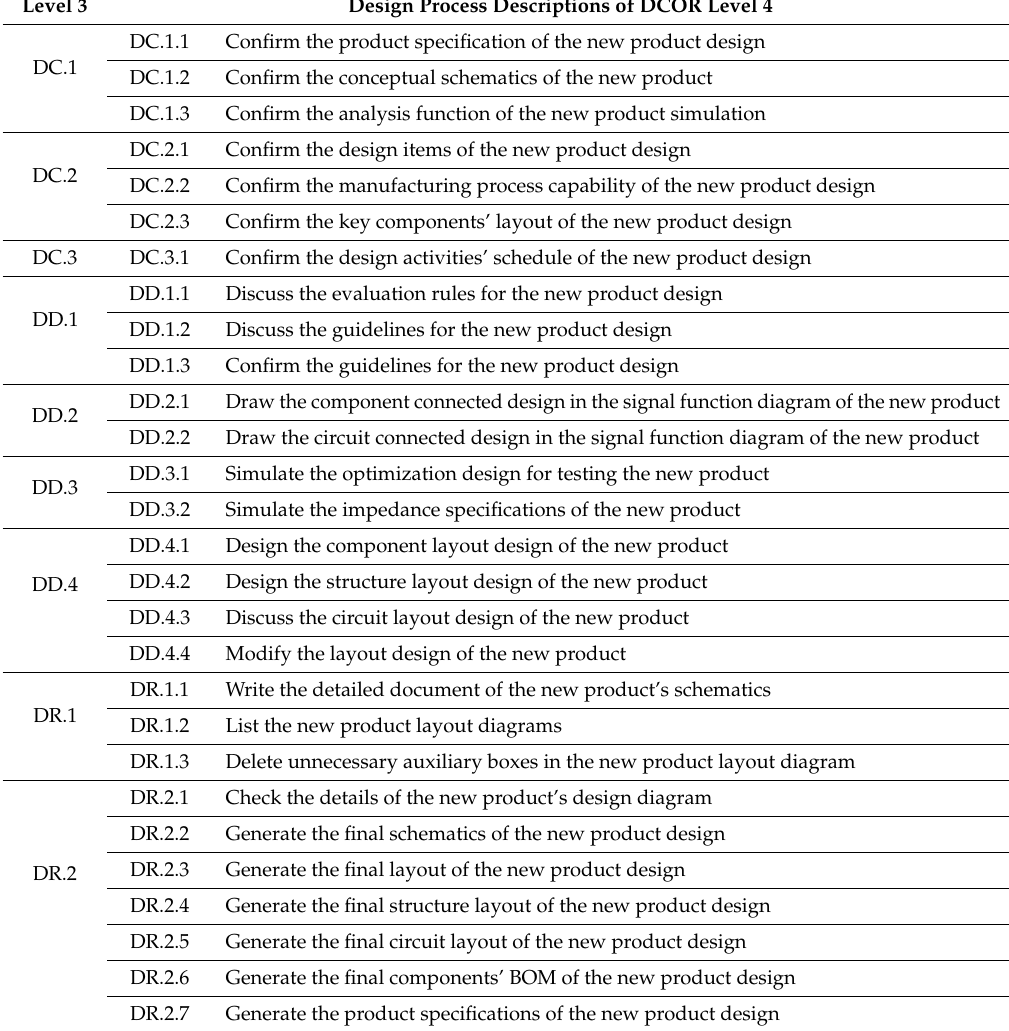
Table 3. Design process of DCOR Level